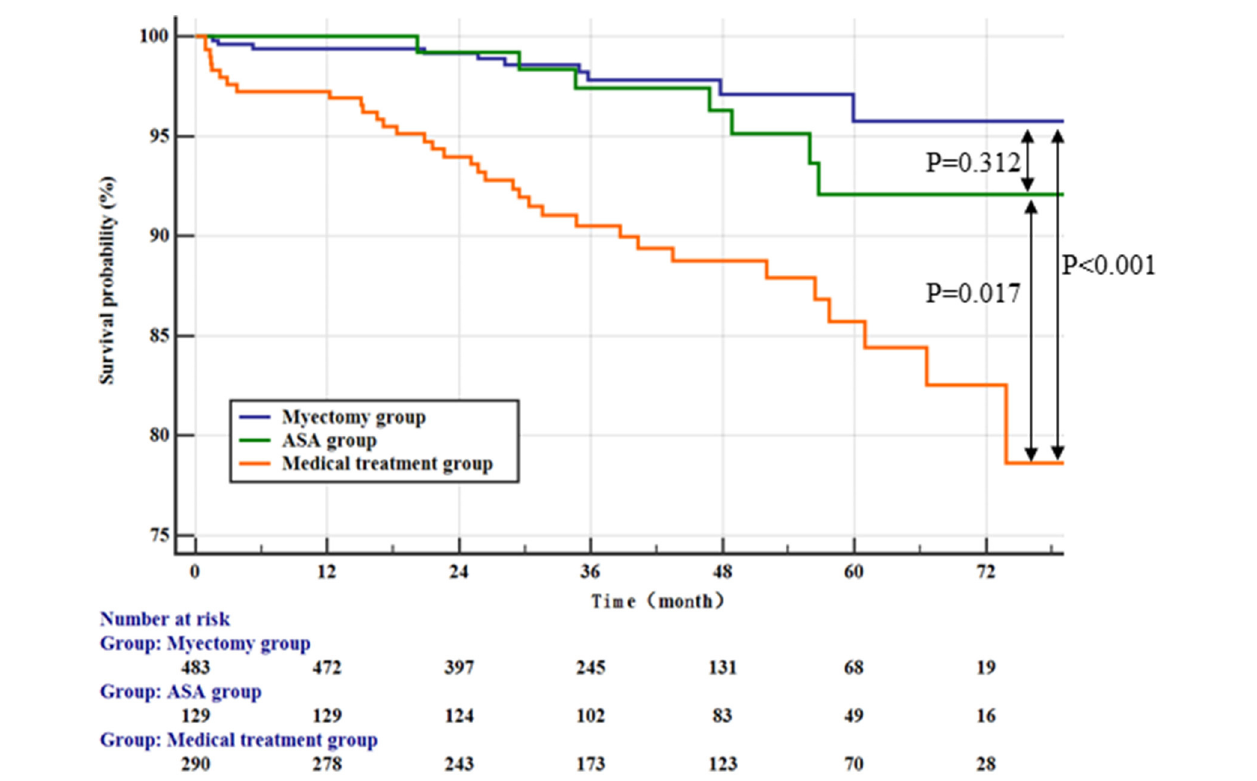
FIGURE 1 | Kaplan–Meier curves comparing the probability of outcomes stratified by treatment strategies.